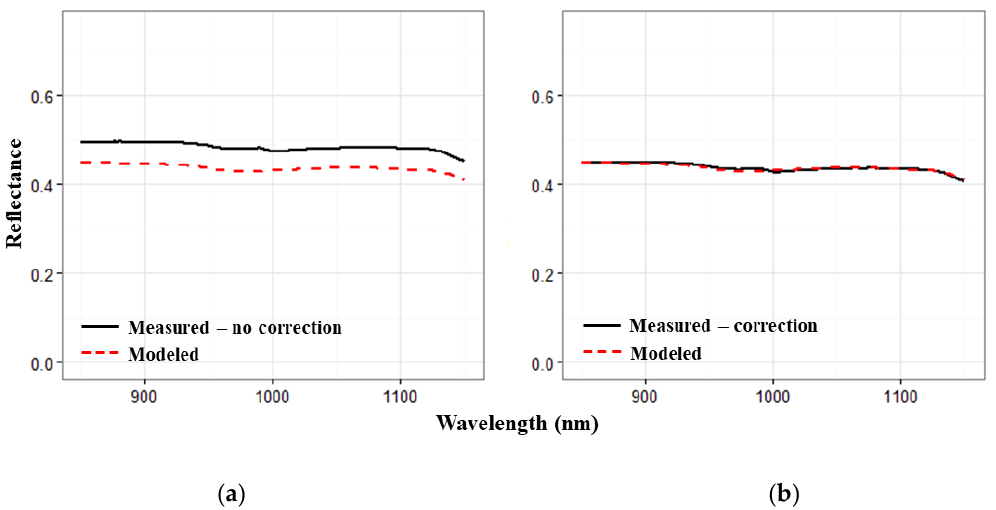
Figure 2. Comparison between measured and modeled leaf spectra in the NIR region (850–1150 nm): ( a ) before PROREF adjustment; ( b ) after PROREF adjustment. The dashed red line represents the modeled leaf spectra as output from PROSPECT-5. The solid black line represents the measured wheat leaf spectra. The modeled leaf spectra were generated for this example figure with the biochemical input parameters measured from a wheat leaf sample: C w = 0.016, C m = 0.004, and N = 1.38.